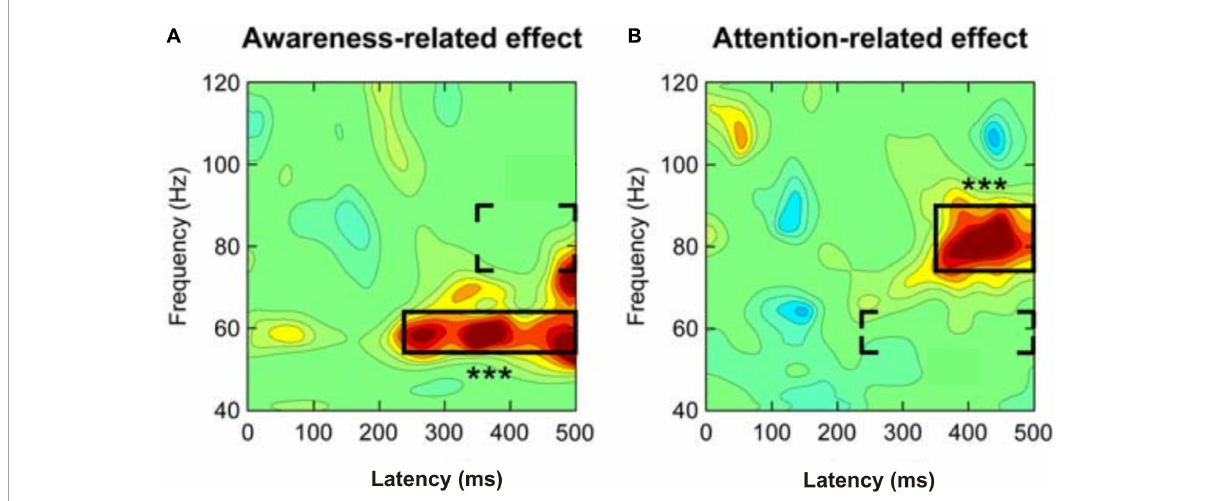
FIGURE2 Separation of (A) awareness-related and (B) attention-related gamma-band activity when humans respond to a faint visual stimulus. Whether attended or not, a stimulus perceived with awareness induced mid-frequency gamma-band activity (about 54–64 Hz) at a latency of about 240 ms after stimulus onset (left panel). If spatial (selective) attention was directed to the stimulus, high-frequency gamma-band activity (about 76–90 Hz) occurred at a latency of about 350 ms after stimulus onset (right panel). In both panels the three stars indicate the highly significant effects in the framed areas. The brackets indicate the areas of a possible attention-related effect added to the awareness effect (left panel) or an awareness-related effect added to the attention effect (right panel). [Modified from Wyart and Tallon-Baudry (2008); their Figure